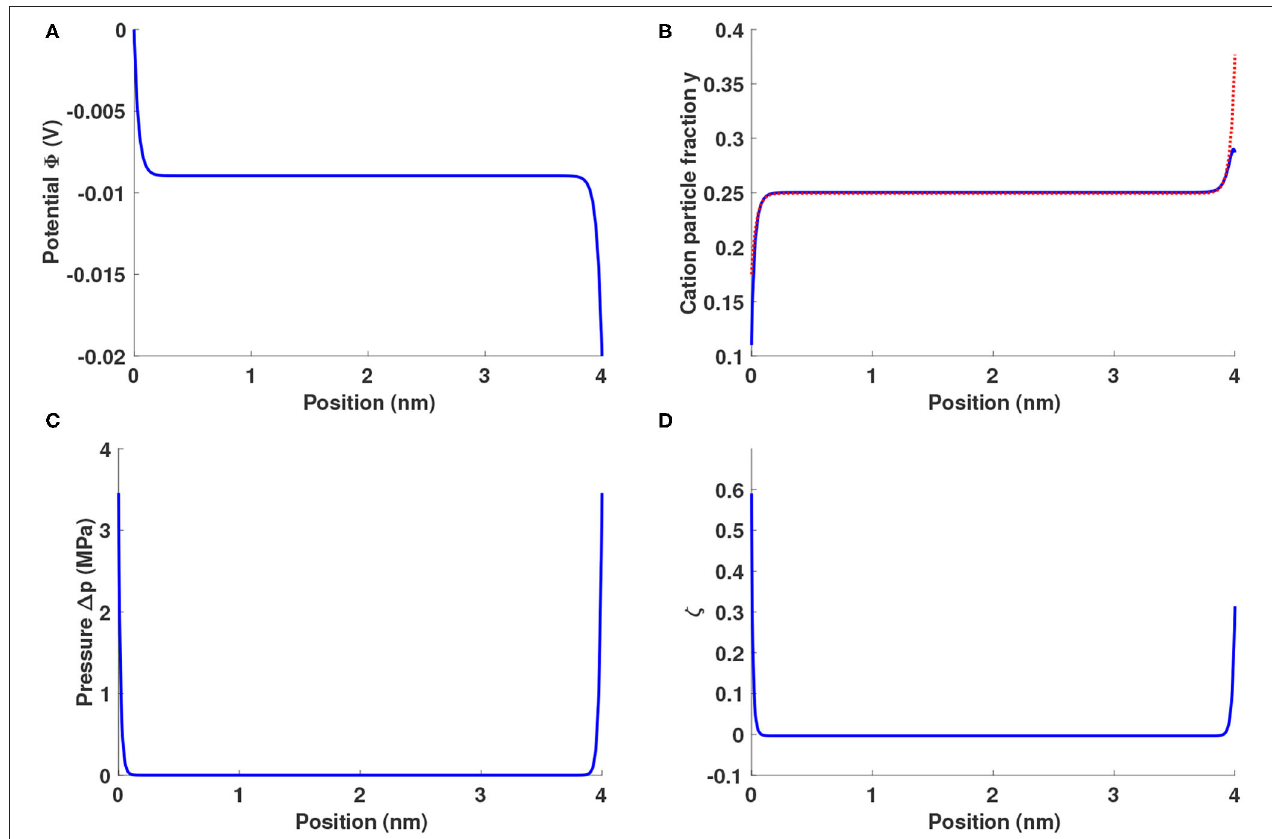
FIGURE 1 | Distributions of (A) potential 8 , (B) cation particle fractions (blue solid line: y + , red dotted line: y Li ), (C) gauge pressure 1 p = p − p bulk , and (D) lithium excess factor ζ for a Li 0.5 bmim 0.5 BF 4 system sandwiched between two planar blocking electrodes under a potential bias of 20